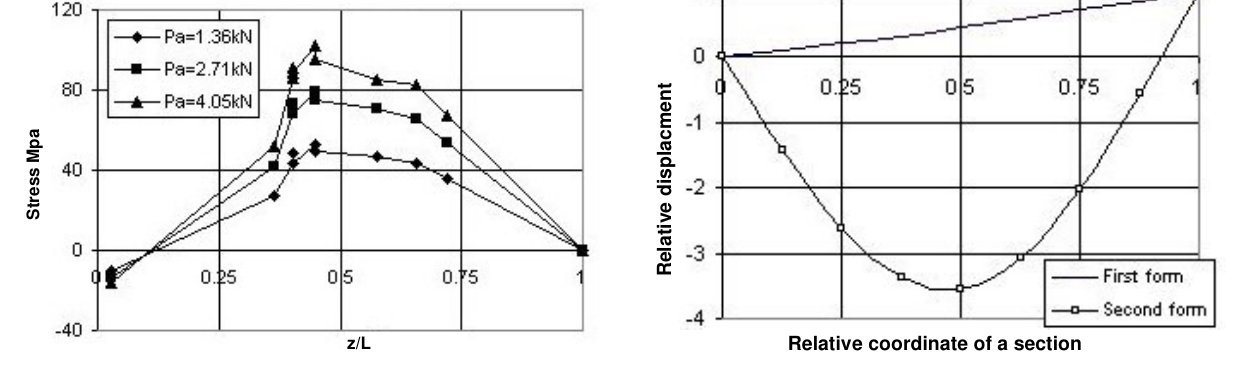
Fig 6. First and second natural forms of